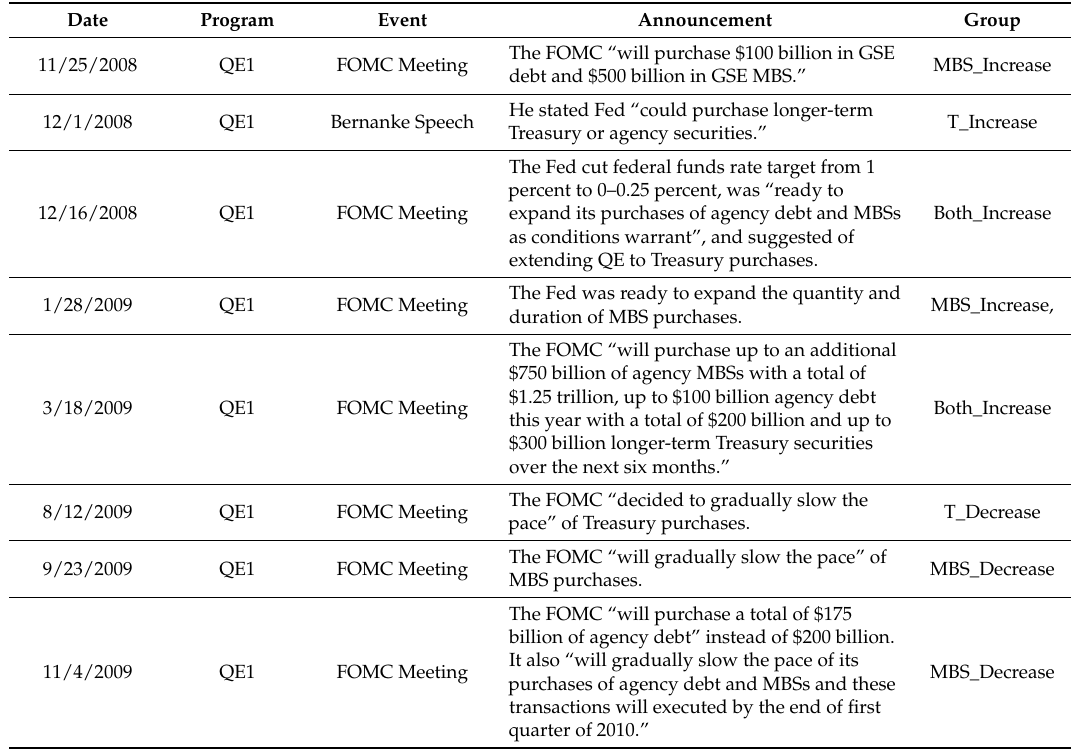
Table A2. The Federal Reserve Bank’s quantitative easing (QE) announcements. This table reports the QE announcement events ordered by event date. There are 35 events in total, and each of them is assigned to a certain QE program, event type and event group. “Increase”, “Decrease” and “Com” tell us if the event is about increasing asset purchases, decrease asset purchases or only a communication to the